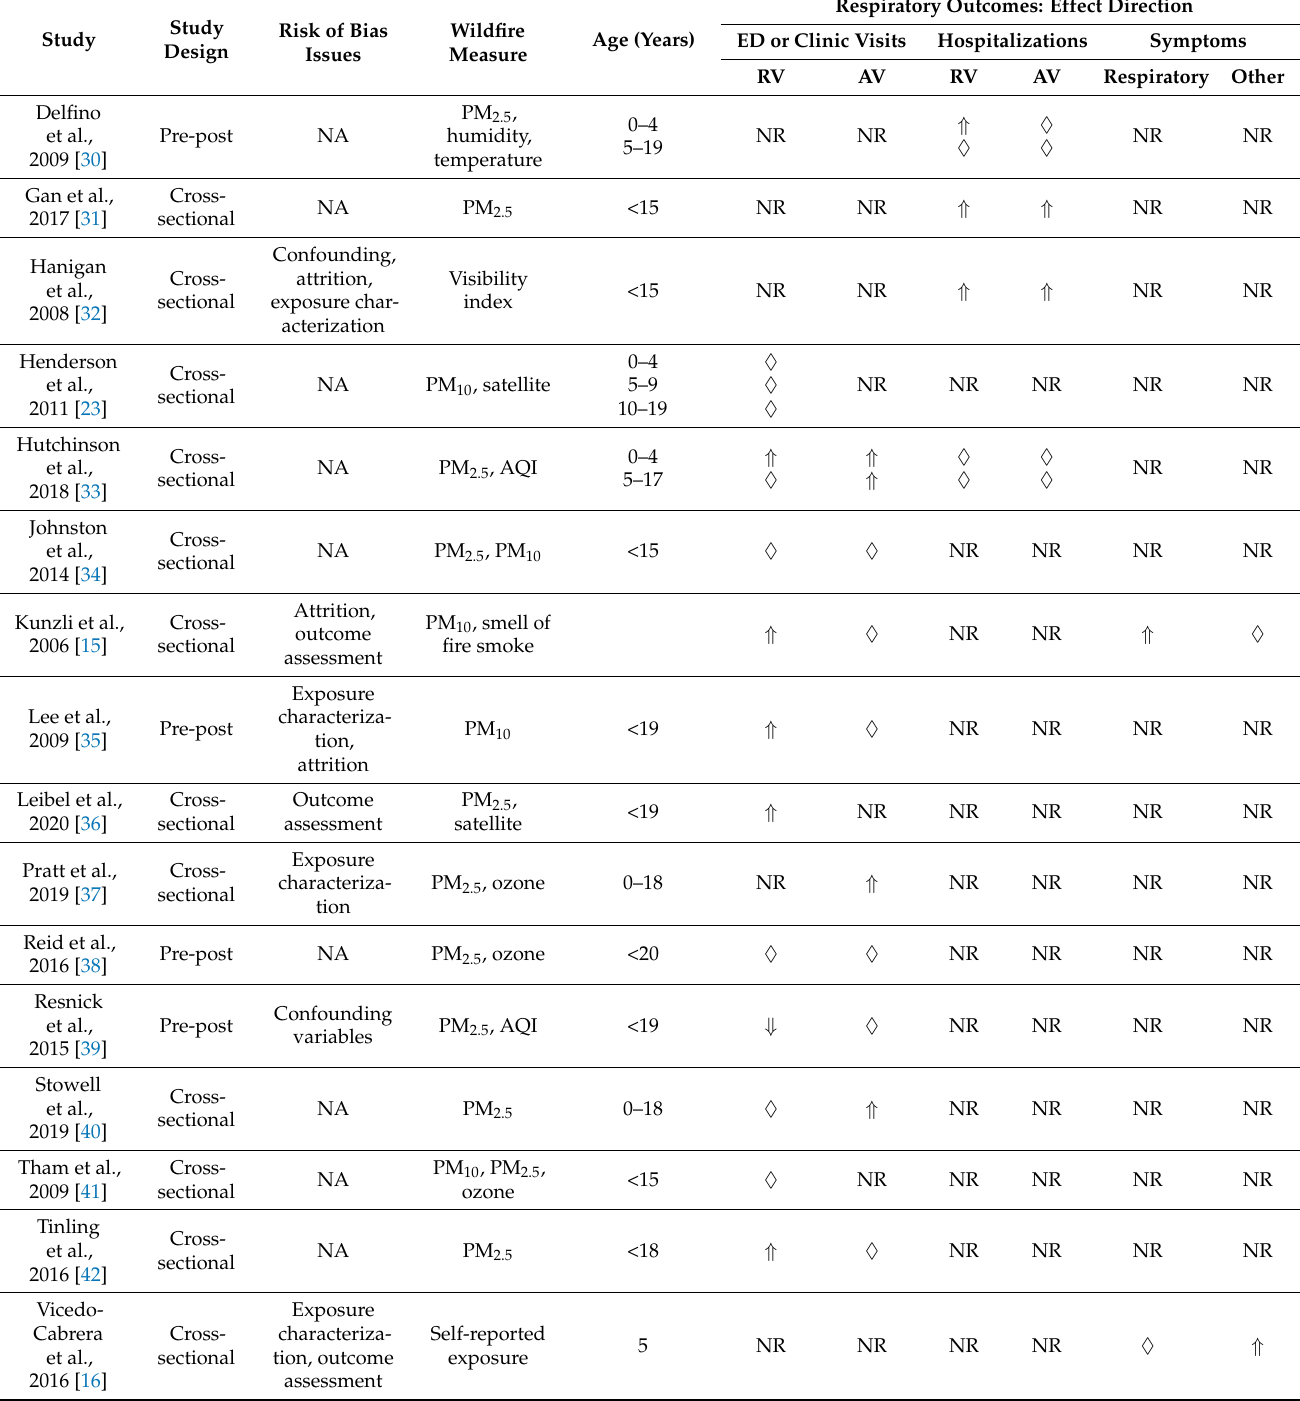
Table 2. Effect direction plot (sorted by alphabetical